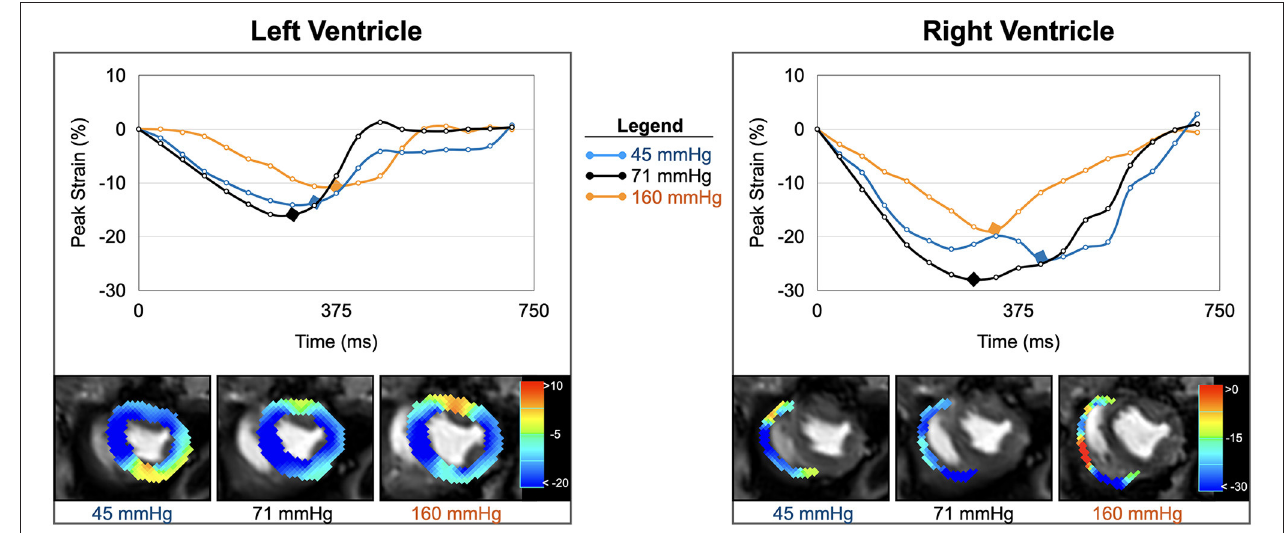
FIGURE 4 | Strain inside and outside the autoregulation zone. Circumferential strain curves and strain overlays at end-systole of one animal are shown for the left and right ventricle. In comparison to baseline (black, 71 mmHg), biventricular strain at low blood pressure (blue, 45 mmHg), and high blood pressure (orange, 161 mmHg) both demonstrate attenuations in peak strain (yellow-red- color in overlay) and prolongations in time to peak strain (marked by diamond in curve).